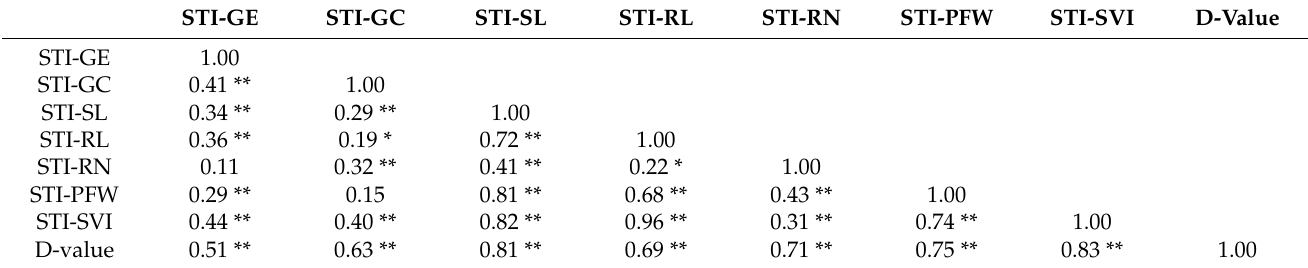
Table 4. Pearson correlation analysis between salt tolerance indexes of germination energy (STI-GE), germination capacity (STI-GC), shoot length (STI-SL), root length (STI-RL), root number (STI-RN), plant fresh weight (STI-PFW), and seedling vigor index (STI-SVI) of 114 rice germplasms in the presence of 120 mM sodium chloride.